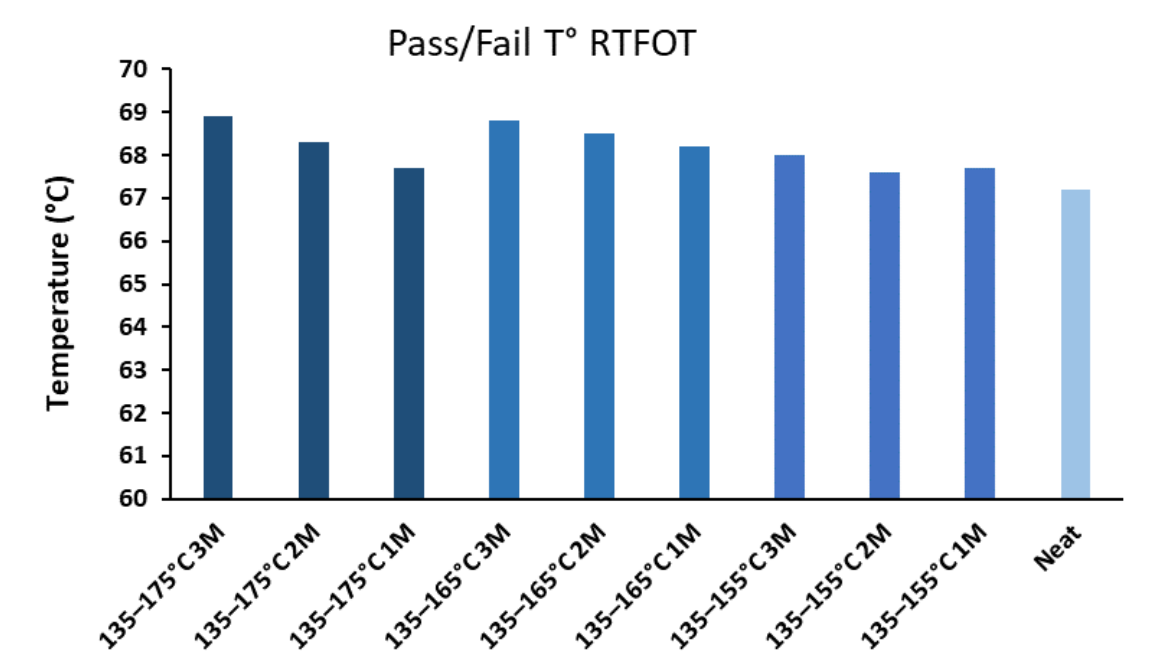
Figure 25. Pass/fail temperature of all samples at the RTFOT-aged stage.